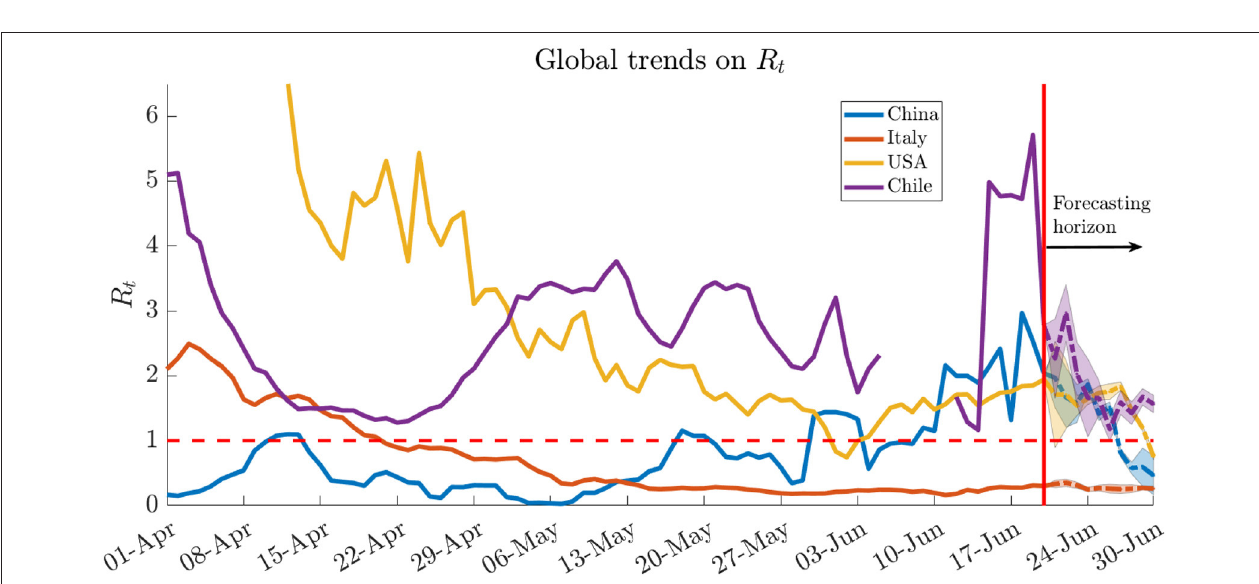
FIGURE 1 | RMSE histograms for assessing the quality of the forecast models for each variable in the 185 countries considered. The red line in each histogram represents the division between models with RMSE ≤ 1. As every country could be associated with one RMSE value, this figure provides a visual idea of the fraction of countries where the data was good enough to train reliable forecast models.